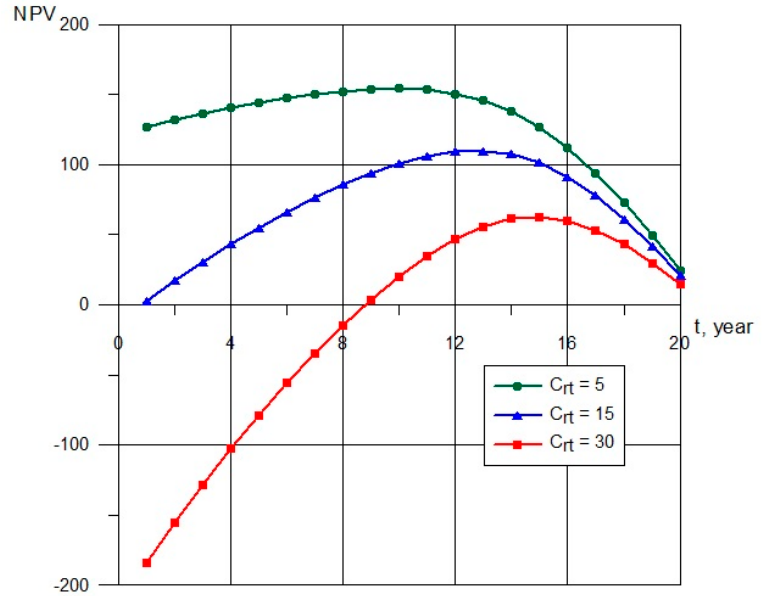
Figure 10. Impact of costs C rt related to diagnostic testing and repair on the change in the NPV index over 20 years of operation, according to scenario 3.